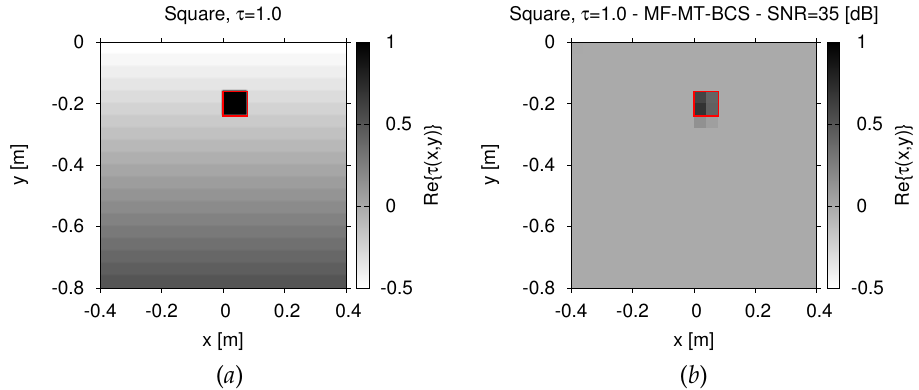
Figure 7. Numerical assessment (“ Square-Shaped ” Scatterer , τ = 1.0, N = 400, SNR = 35 dB)—Actual ( a ) and retrieved ( b ) dielectric profile by the MF-MT-BCS when considering a smoothly-varying inhomogeneous soil.